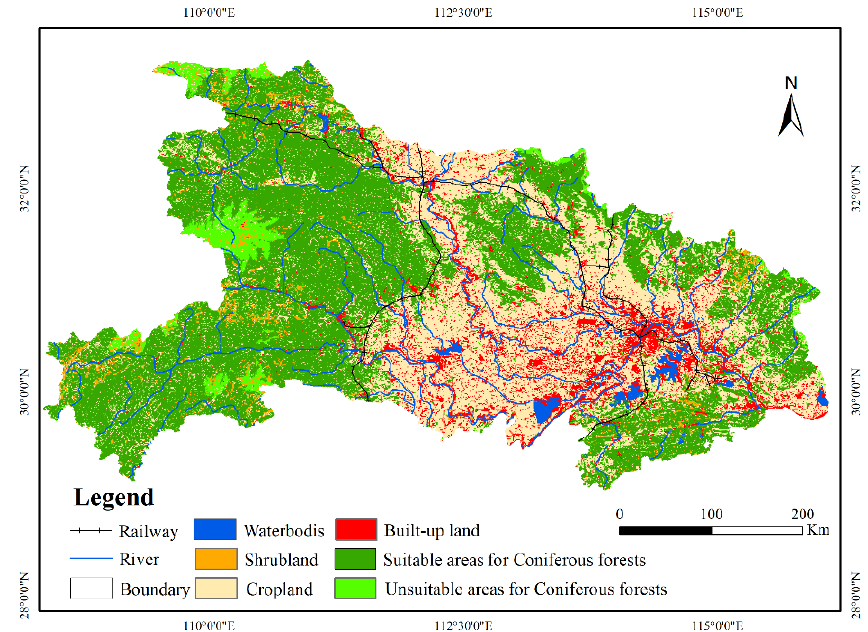
Figure A5. The distribution map of land use/land cover and suitable area of main coniferous forests in the study area in 2015.